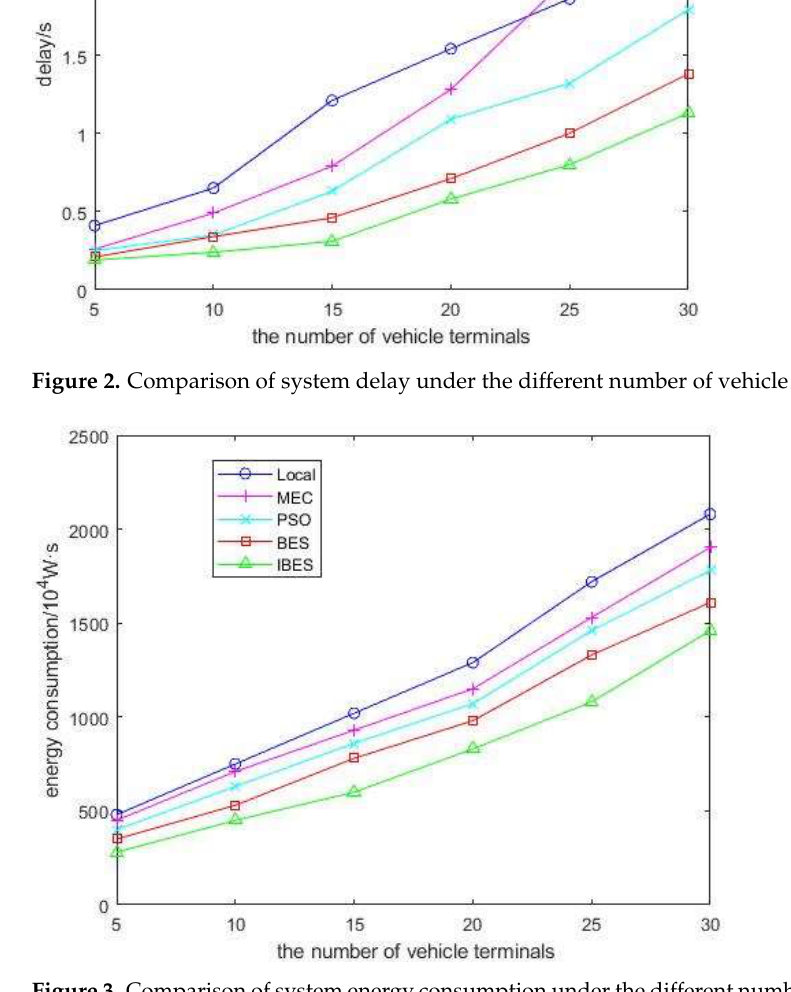
Figure 3. Comparison of system energy consumption under the different number of vehicle ter- minals.